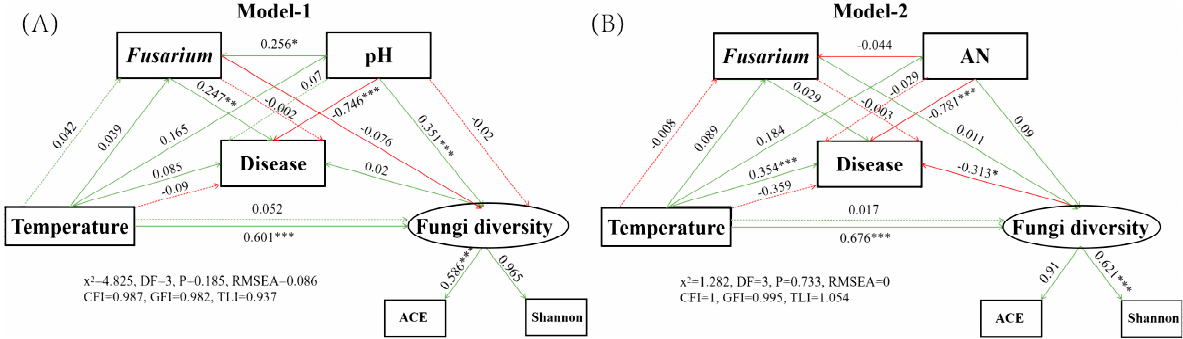
Figure 6. Structural equation modeling (SEM) analysis showed the contributions of Fusarium, temperature (soil temperature), soil and fungi diversity to the sugarcane disease. The disease was pokkah boeng disease of sugarcane. Soil was represented by mainly compositions including pH and AN (Available Nitrogen), and Model − 1 ( A ) and Model − 2 ( B ) were constructed respectively. Fungi diversity included ACE and Shannon index. The number above the arrow indicates the normalized path coefficient. p − value: * p < 0.05; ** p < 0.01; *** p < 0.001.